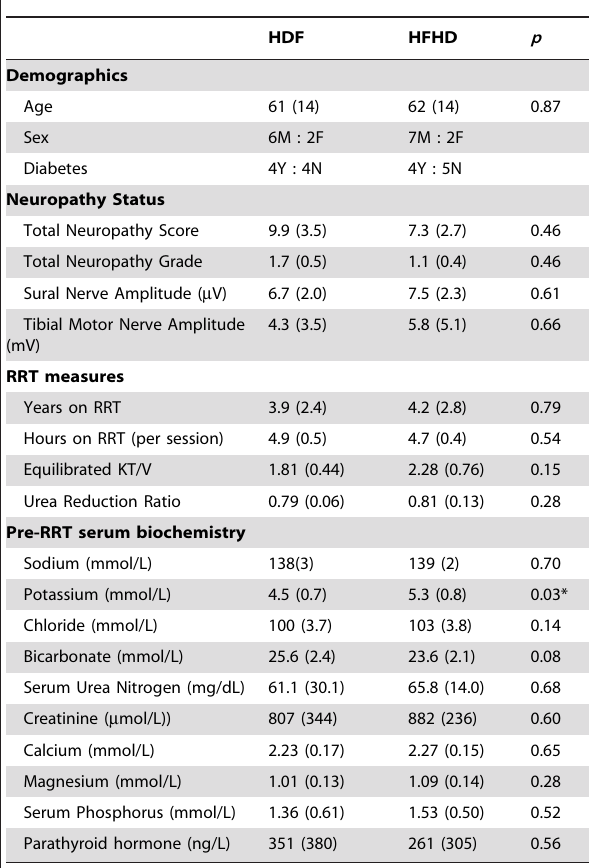
Table 1. Patient